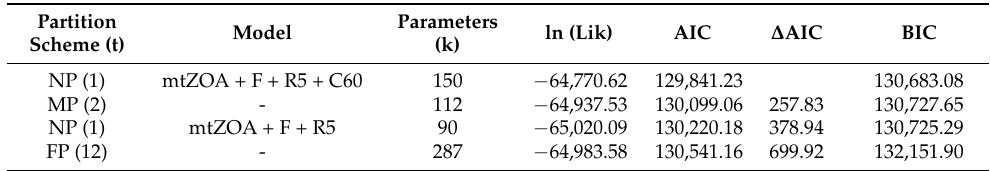
Table 2. Models, partitioning schemes, and model comparisons of the maximum-likelihood anal-